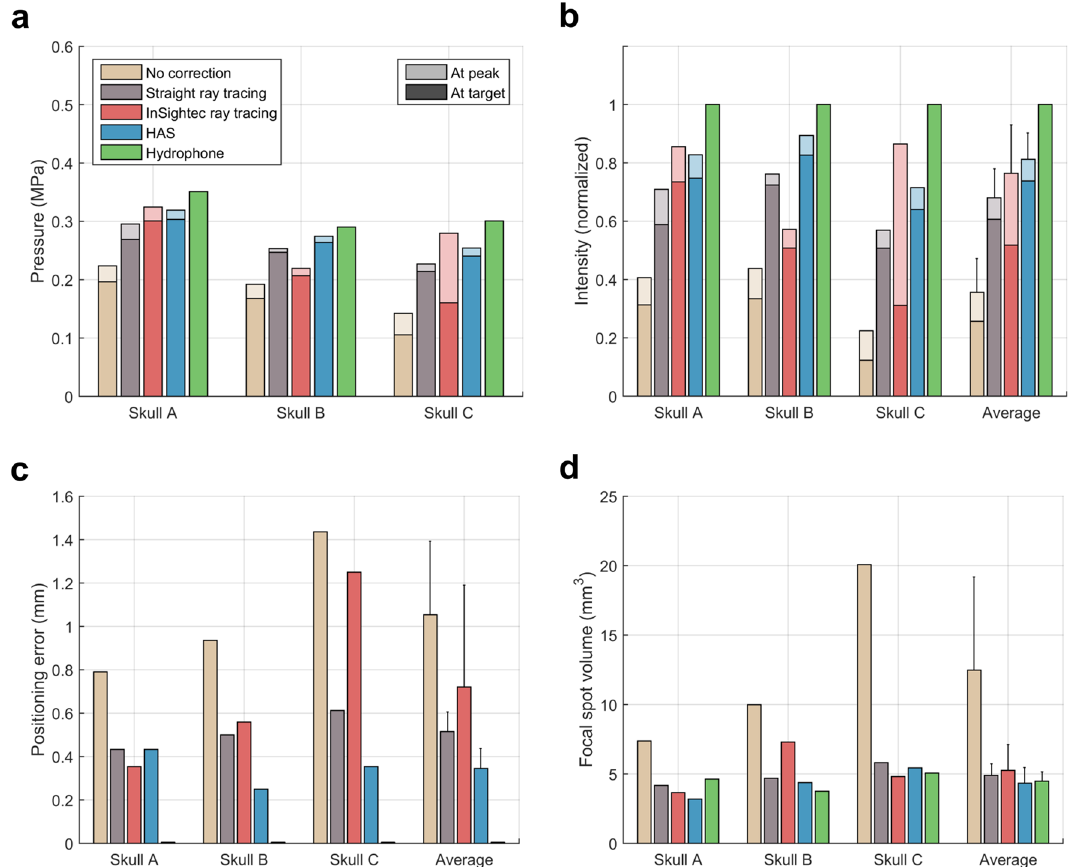
Figure 3. Quantitative metrics used to evaluate the phase correction methods. ( a ) Target and peak pressure (shown with darker and lighter colors, respectively) when operating the transducer at 20 W of electrical power. ( b ) Target and peak intensity normalized to the hydrophone method. ( c ) Focal spot positioning error. ( d ) Focal spot volume. Standard deviation bars are shown.